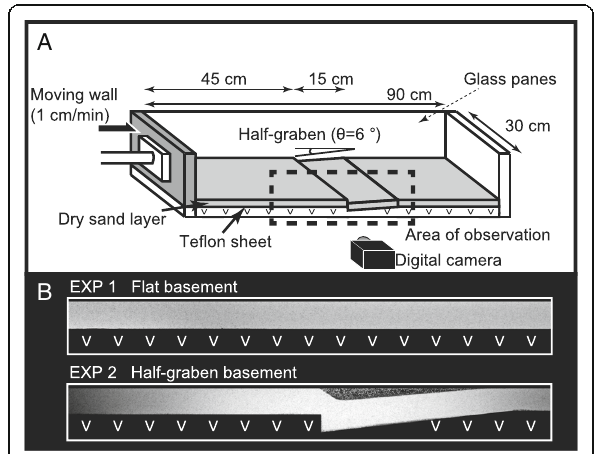
Fig. 2 Outline of sandbox apparatus under initial conditions. a Diagram of our experimental apparatus. Dry sands were filled on the basement surface pasted by a Teflon sheet. The right wall was fixed, and the left side wall was displaced at a uniform speed (1 cm/min). The 2D deformation around the half-graben structure area was continuously recorded with a digital camera and analyzed to visualize the deformation, especially fault activity. b Photographs showing initial setup of the analog experiments for half-graben basement without trench-fill (EXP 2), and flat basement reference model (EXP 1)